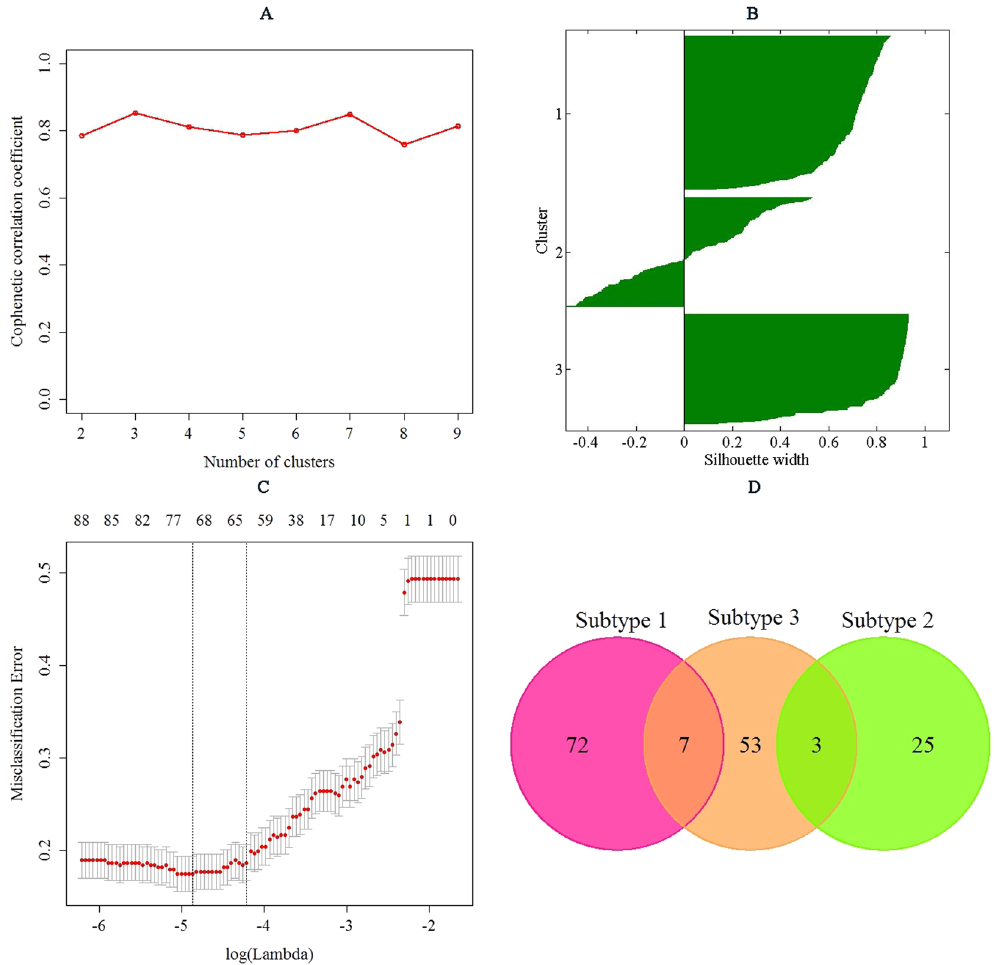
Figure 4. ( A ) Cophenetic correlation coefficient for clusters k = 2 to k = 9. The figure demonstrates that maximum cophenetic correlation coefficient occurred for cluster k = 3. ( B ) Silhouette plot for the robust cluster. ( C ) The misclassification error rates in the jackknife test. Each dot represents a lambda value along the path, with error bars to give a confidence interval for the misclassification error rate. This figure illustrated that the highest accuracy (overall misclassification error) was 82.54% by the jackknife test. ( D ) Venn diagram of different biomarkers between three molecular subtypes. This figure illustrated that among 170 unique biomarker genes, 7 biomarker genes were in common between subtype 1 and subtype 3, and 3 biomarker genes were in common between subtype 2 and subtype